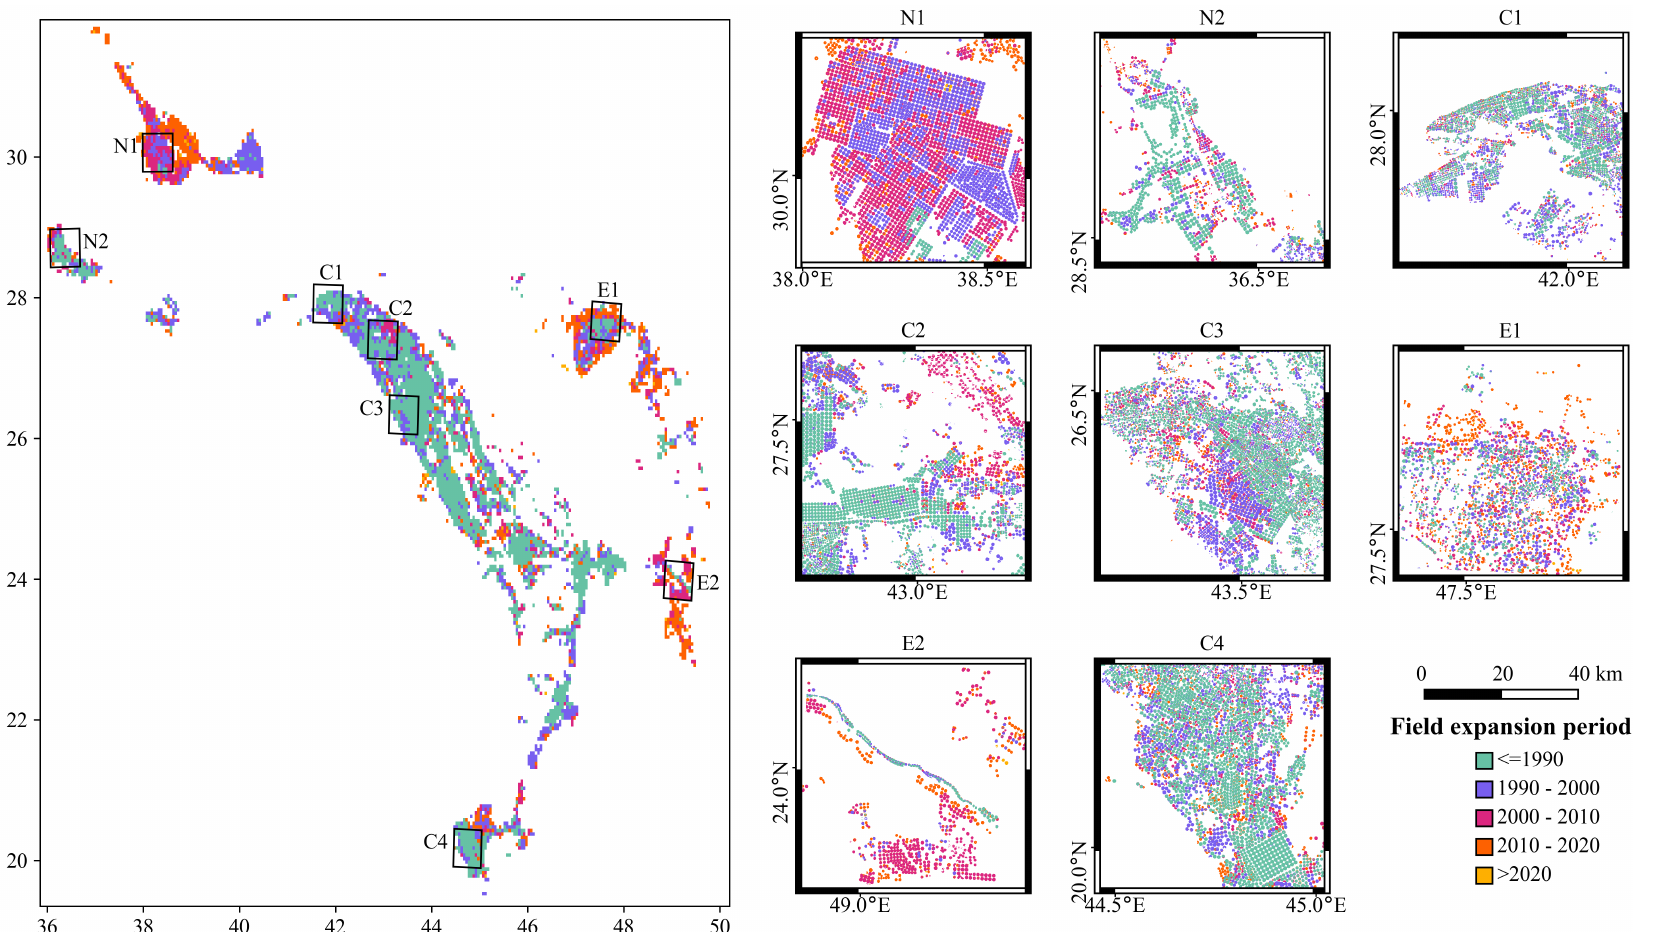
Figure 11. Center-pivot field expansion map. The map was generated by identifying the year that the framework first detected each pixel within a field. The national scale map ( left ) was resampled to 0.05 ◦ resolution using the mode resampling method for visualization purposes, while the regional maps ( right ) show the data at 30 m resolution, with the scale bar shown in the lower right